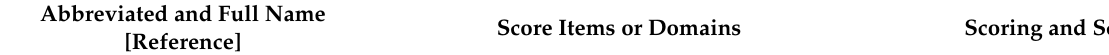
Table 1. Summary of the characteristics of quality of life questionnaires used in the reviewed